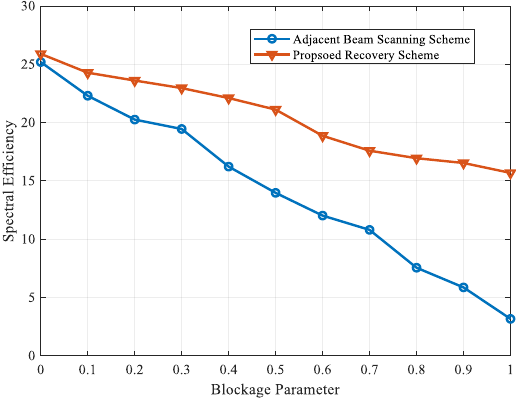
Figure 4. Spectral efficiency for various blockage parameters.